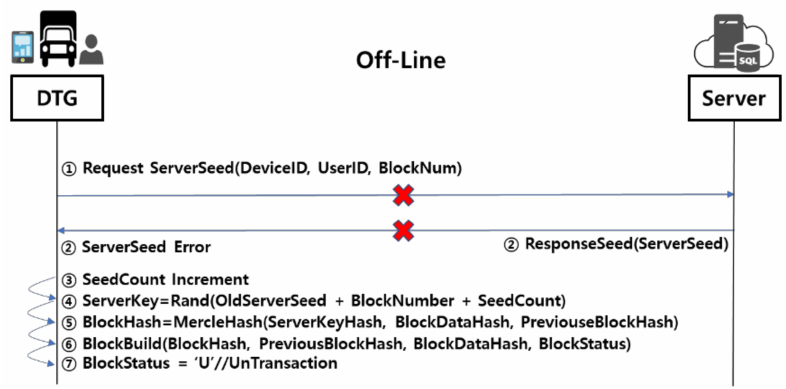
Figure 6. Off-Line process for a block